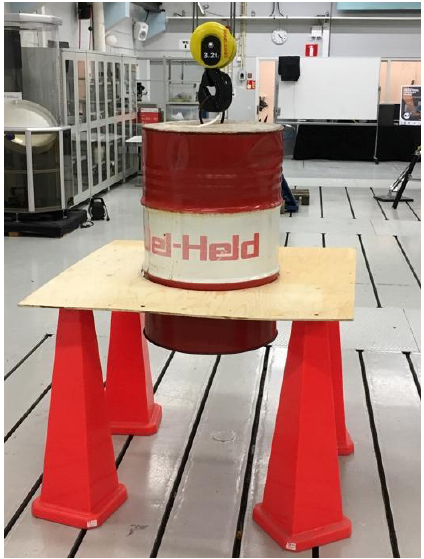
Figure 5. Early prototyping and concept creation for the test rig. Probe 34.